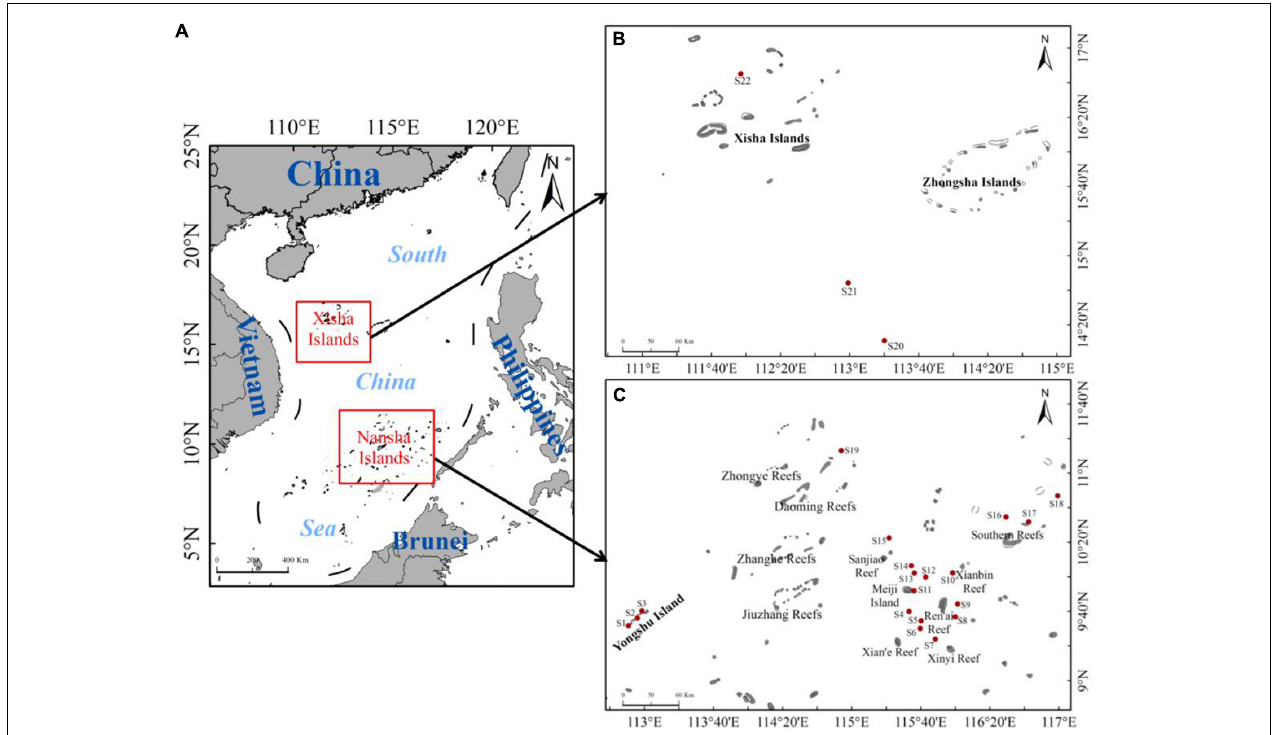
FIGURE 1 | (A) Location of sampling sites in the South China Sea (SCS). (B) Three sampling sites near Xisha Islands. (C) Sampling sites around Nansha Islands in